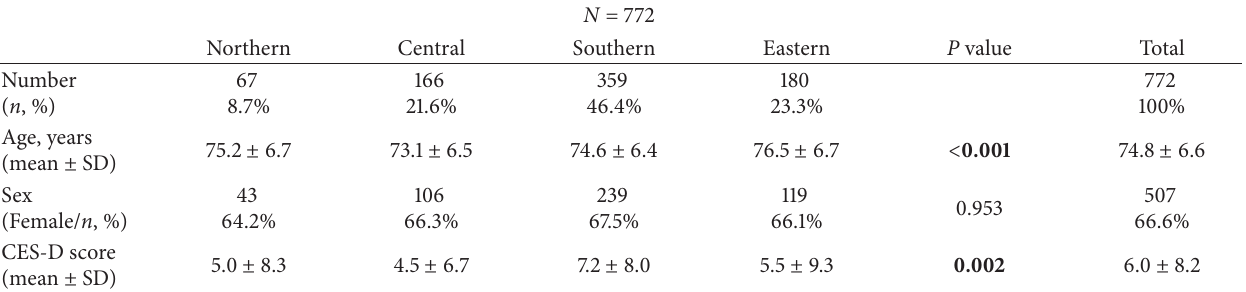
Table 2: Demographic characteristics of recruited aged participants #